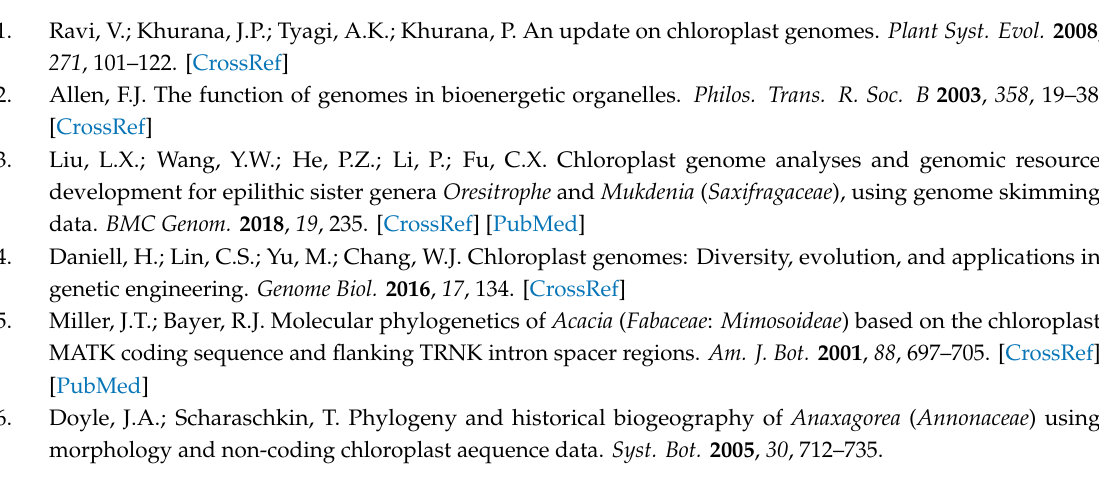
Table S1: Sampled Gramineae species along with their GenBank accession for cp genomes in this study. Table S2: Summary of polymorphisms detected among three Phalaris cp genomes. Note: Tn, Transition; Tv, Transversion; In / Del, insertion or deletion. Table S3: Large indels among three Phalaris cp genomes. Note: A, Position numbers refer to the Phalaris aquatica cp genome; B, Position numbers refer to the Phalaris arundinacea (Tetraploid) cp genome; C, Position numbers refer to the Phalaris arundinacea (Hexaploid) cp genome; The listed indels were filtered with the criterion that more than 15 bp length, or occurs at the coding regions. Table S4: RSCU summary of the three Phalaris cp genomes. Table S5: Chloroplast transcripts by RNA-Seq of the three Phalaris accessions. Table S6: Transcript diversity revealed by RNA editing (RE). Figure S1: MAUVE alignment of three Phalaris cp genomes. Within each of the alignment, local collinear blocks are represented by blocks of the same color connected by lines. Figure S2: Nucleotide variability (Pi) values among three Phalaris cp genomes. Figure S3: Codon usage of the three Phalaris cp genomes using 72 protein-coding